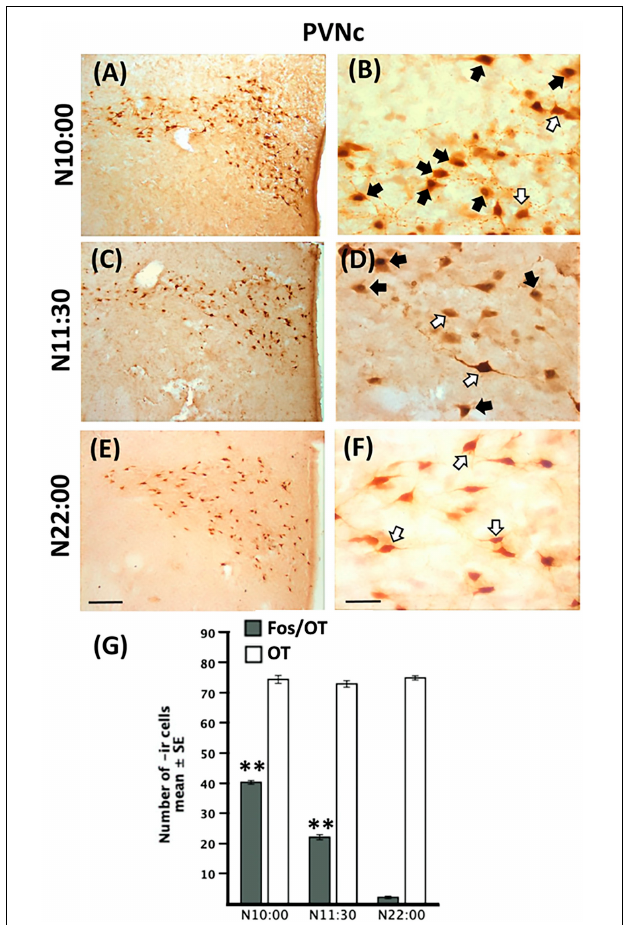
FIGURE 4 | Induction of Fos-/OT-ir cells in PVNc before nursing time. Photomicrographs of representative sections of the PVNc at the time of nursing (10:00, A ), 1.5 (C) and 12 (E) h after nursing and magnifications of the respective time points (B,D,F) . Note the increase of Fos-/OT-ir cells just before (A,B) but not 12 h after (E,F) nursing. (G) Quantitative analysis of OT- and Fos-/OT-ir at the time of nursing (N10:00) and 1.5 (11:30) and 12 h (N22:00) h after. White arrow, OT-ir; black arrow Fos-/OT-ir. ∗∗ P < 0.01, denotes significant difference between Fos-/OT-ir cells between N10:00 and N11:30 groups in comparison to N22:00 group. Scale bar (A,C,E) , 100 µ m; (B,D,F) , 50 µ